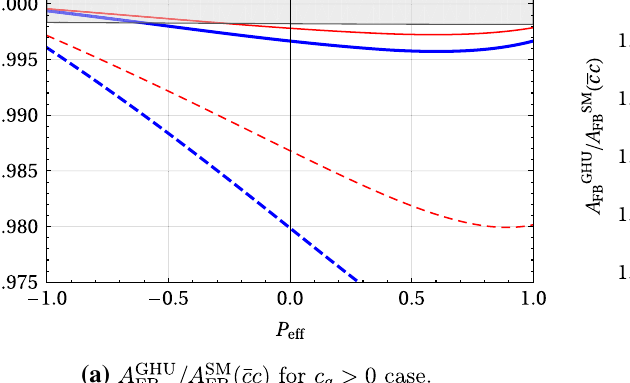
Fig. 3 Ratio of the forward–backward asymmetry in the GHU model respectively. Blue-thick and red-thin lines correspond to θ H = 0 . 10 and to that in the SM with polarisation beams for the e + e − → ¯ cc process. 0 . 08, respectively. The gray band indicates the statistical uncertainty at √ s = 250 GeV with 250 fb − 1 data The left figure shows the c q > 0 case and the right figure shows the √ c q < 0case.Solidanddottedlinesarefor s = 250 GeVand500 GeV, For the ¯ cc final state, the forward-backward asymmetry ( ¯ cc ) decrease from the A SM ( ¯ cc ) is also measured. The A GHU FB FB ( ¯ cc ) increase from the A SM ( ¯ cc ) for c q > 0. In contrast, A GHU √ FB FB s = 250 GeV with P eff = + 0 . 887 for c q < 0. At ( ¯ cc ) = 0 . 700 and with 250 fb − 1 lumi- polarised beam, A SM FB nosity, the statistical uncertainty is 0.16%. The deviations ( ¯ cc ) from A SM ( ¯ cc ) are − 0 . 38%, − 0 . 31% and of the A GHU √ FB FB > 0 and θ = 0 . 10, 0 . 09 and 0 . 08 at − 0 . 25% for c s = q H 250 GeV with P eff = + 0 . 887. For c q < 0 and θ H = 0 . 10, √ s = 250 GeV with P eff = + 0 . 887, the 0 . 09 and 0 . 08 at deviations are + 1 . 68%, + 1 . 25% and + 1 . 03%. The polarisa- / A SM ( ¯ cc ) are plotted in tion dependence of the ratio A GHU √ FB FB s = 250 GeV, 500 GeV and Fig. 3 and the deviations at 1 TeV are summarised in Tables 11, 12 and 13, respectively. ¯ bb process, the cross section in the SM is For the e + e − → √ σ SM ( ¯ bb ) = 1.77 pb and 1.02 pb at s = 250 GeV with unpo- larised and polarised ( P e − = + 0 . 8 and P e − = − 0 . 3) beams, √ s = 250 GeV respectively. The statistical uncertainty at and 250 fb − 1 luminosity with P e − = + 0 . 8 and P e + = − 0 . 3 beam are 0.20 %. For this process, the cross sections in the GHU model with c q > 0 and c q < 0 cases both decrease √ s = 250 GeV from that in the SM. The deviations at